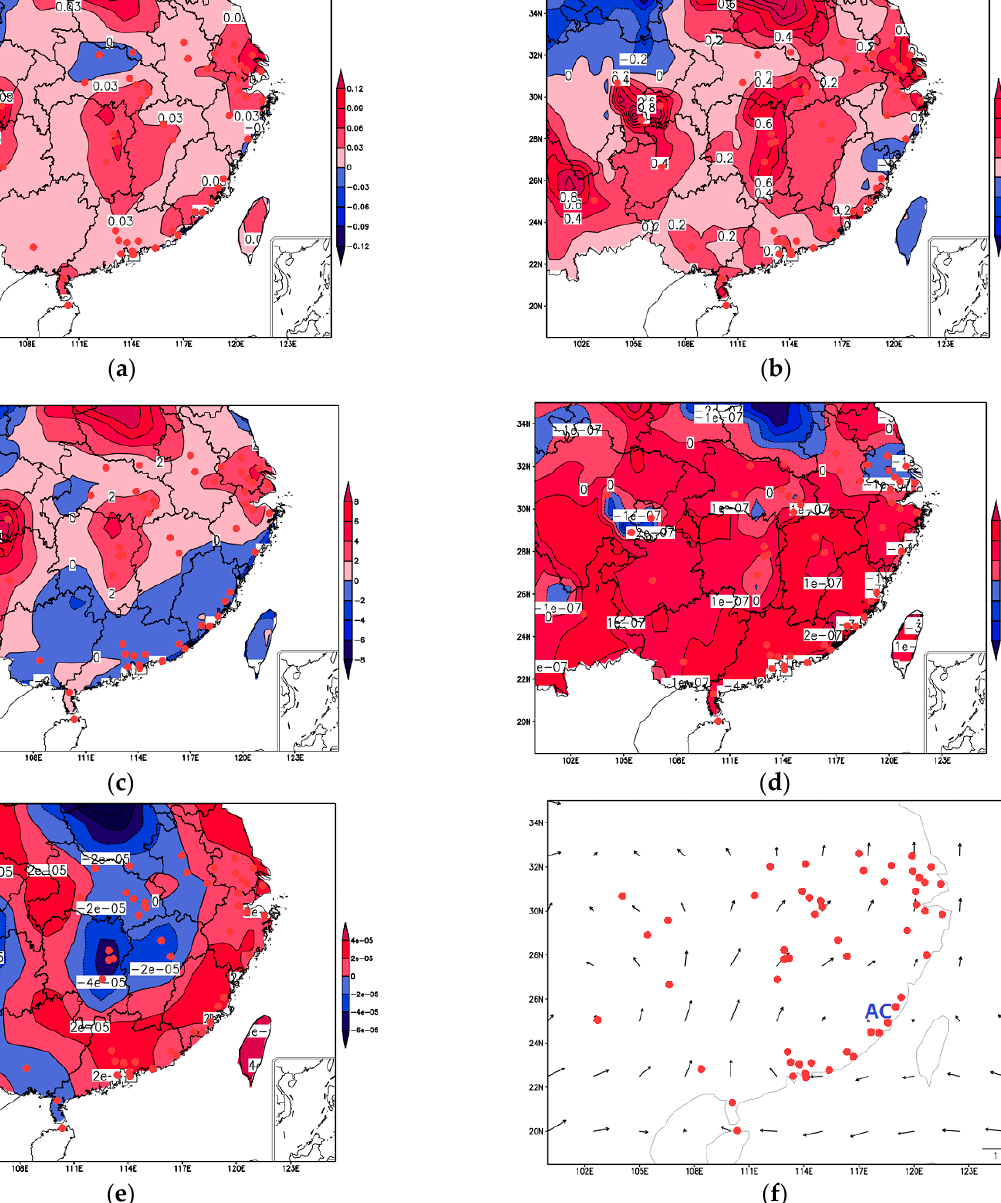
Figure 5. Trends of annual maximum NDVI over the period 1998–2014 (ndvi·year − 1 ).